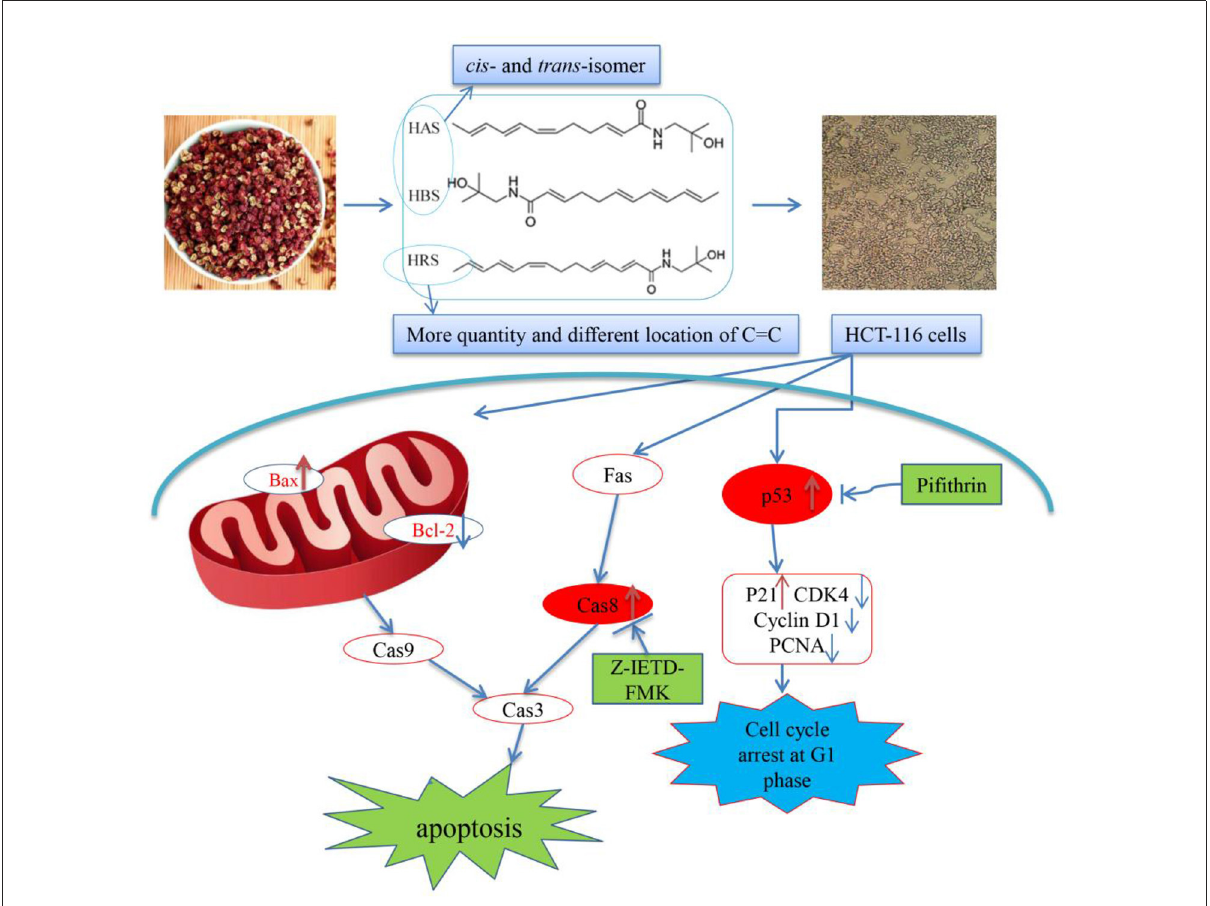
FIGURE10 Proposed mechanism of the induced apoptotic effects of hydroxy- γ -sanshool (HRS) on HCT-116 cells.